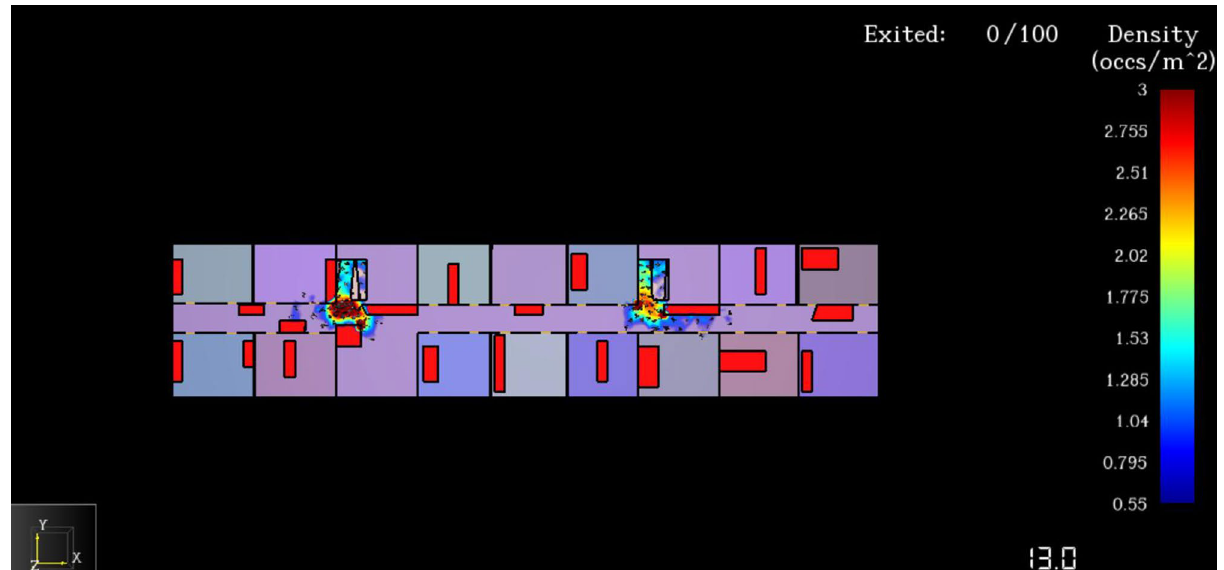
Figure 18. Personnel density map at evacuation time of 13.0 s.